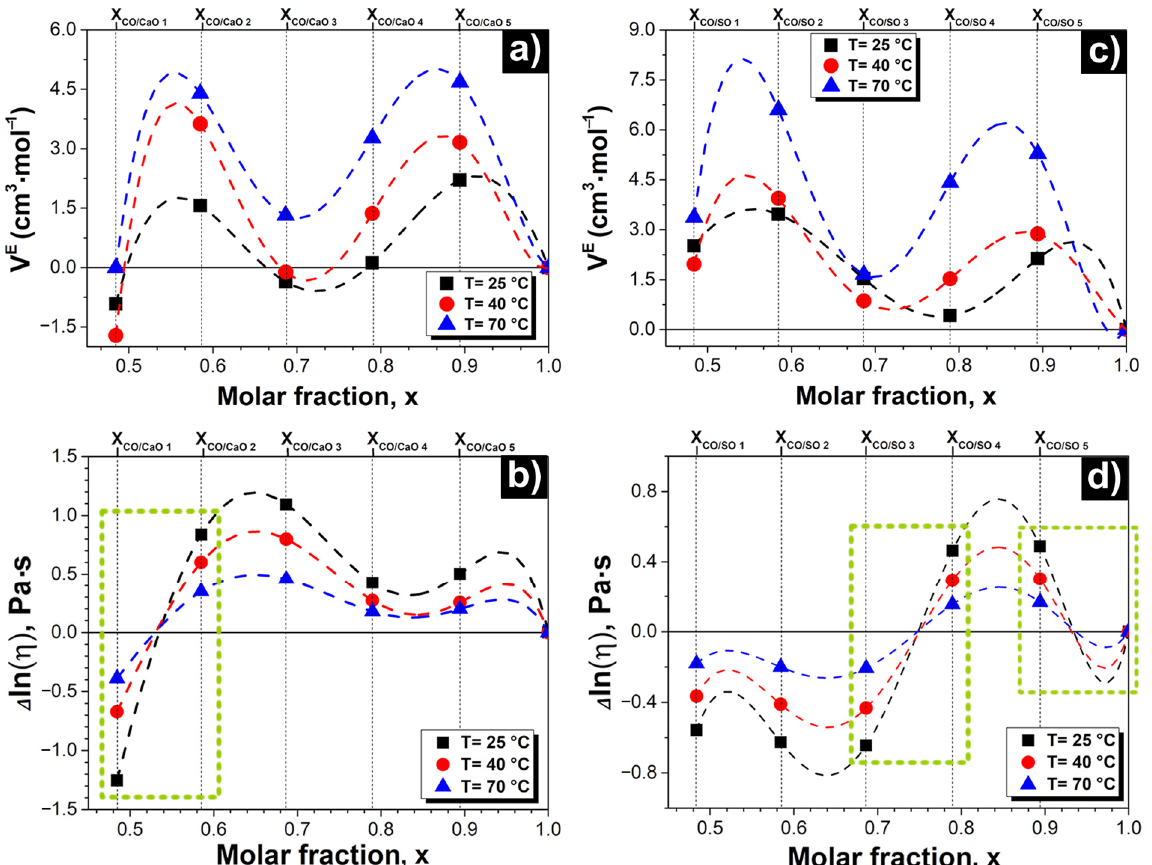
Figure 4. Excess molar volume ( V E ) and viscosity deviation ( Δ ln( η )) of binary mixtures at different temperatures: CO/CaO ( a , b ) and CO/SO ( c , d ).